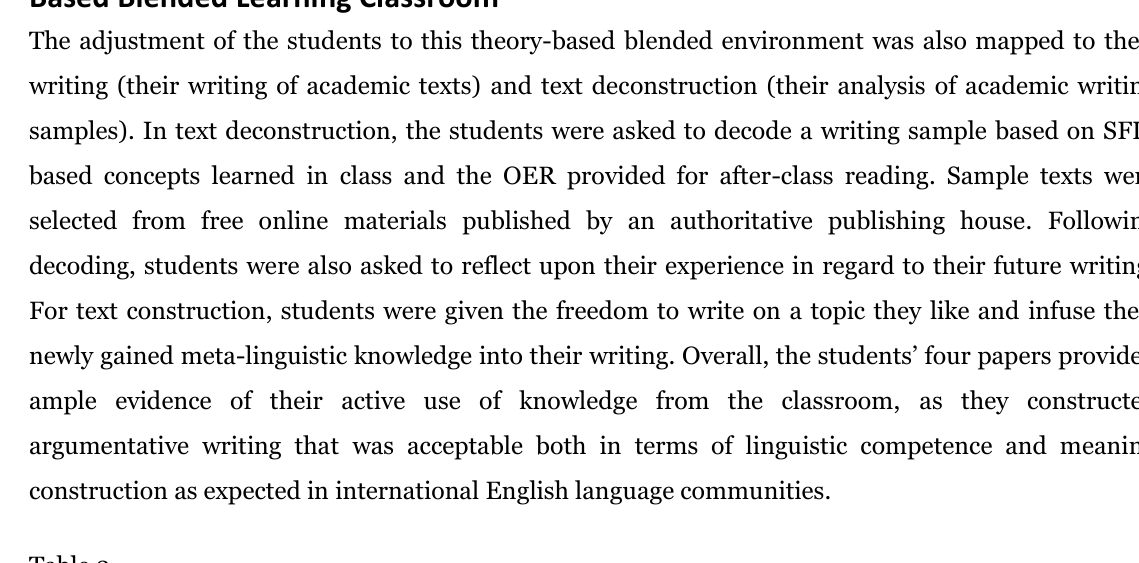
Charlie’s Understanding of the Interpersonal M eaning in the Blended Learning Environment Reflections on a writing sample, which she coded with SFL-based